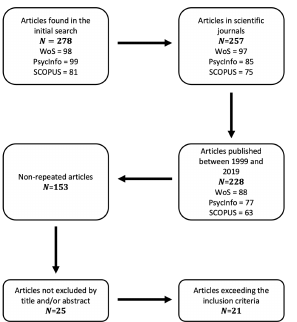
Figure 1. Data collection